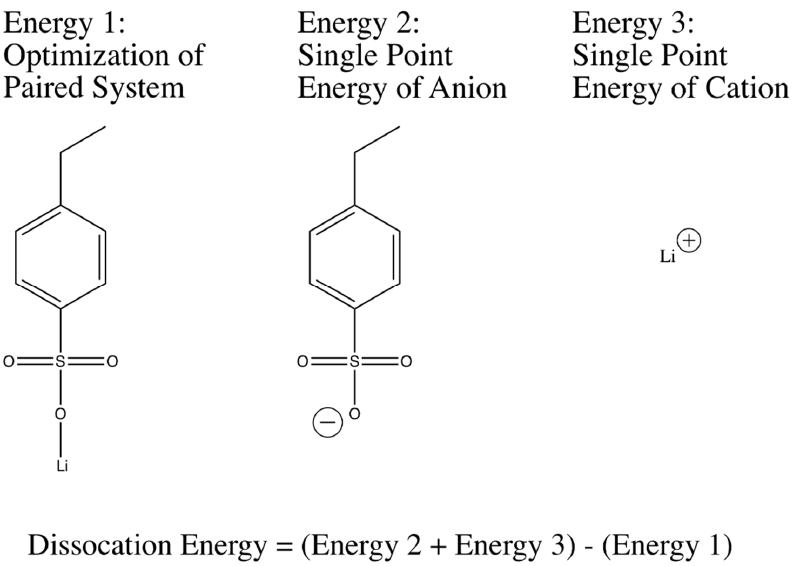
Figure 10. Schematic to describe system states used in DFT calculations to determine a relative dissociation energy for a lithium styrene sulfonate (LiSS) ion pair.